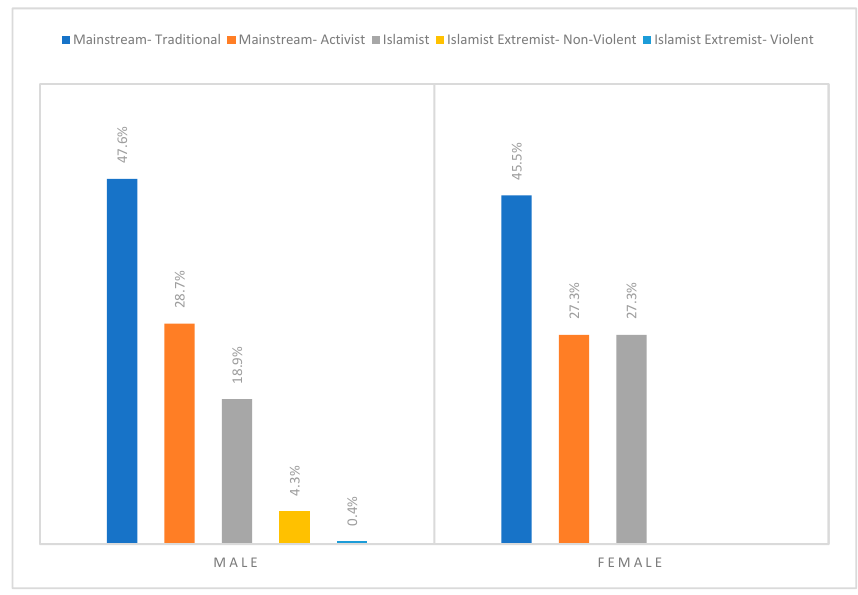
Figure 1. Islamic worldviews among male and female prisoners.